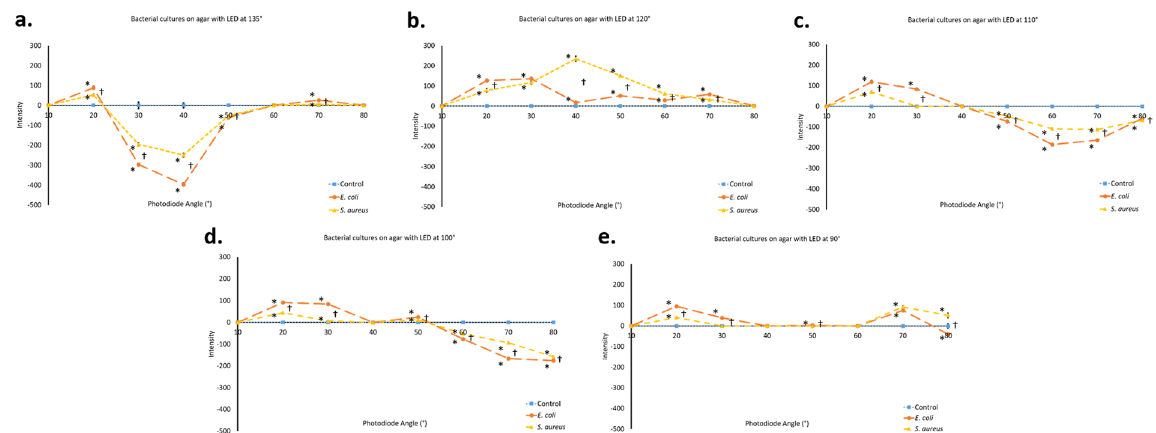
Figure 5. Identification of bacteria in a pure culture. ( a – e ) Data obtained from the photodiode array designed by scanning LB agar either sterile or with an inoculation of E. coli or S. aureus . Incident light angle was changed for each of the five data sets; 135° ( a ), 120° ( b ), 110° ( c ), 100° ( d ), and 90° ( e ). At each individual incident light angle, significant differences result between bacterial inoculation and control samples as well as between each species of inoculation; E. coli or S. aureus . As expected, the trend changes as the incident light angle changes, but distinct differences are maintained despite changing trends with changing incident angles. One data point is considered to be the average of 12 readings from each photodiode (3 s scan). Each of five agar samples was scanned at three unique locations for 3 s at each location. Error bars represent standard error of the mean. * is shown to the left side of each data point indicating significant difference (p < 0.05) between E. coli vs. control samples or between S. aureus vs. control samples. † is shown to the right side of each data point indicating significant difference (p < 0.05) between E. coli vs. S. aureus